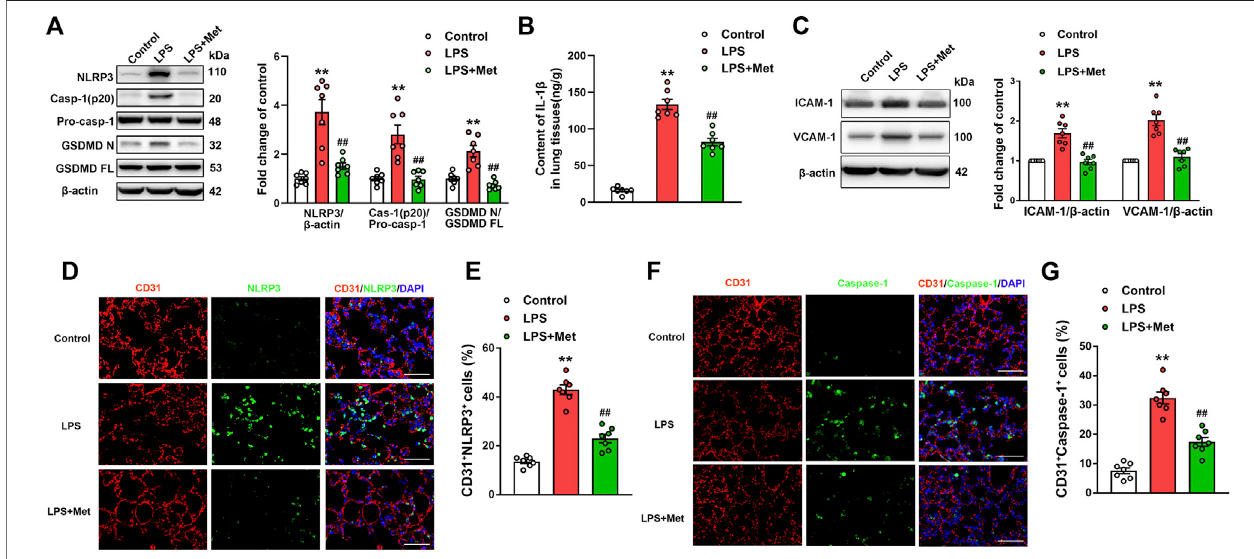
FIGURE 2 | Metformin reduces the LPS-induced release of pyroptotic proteins and vascular adhesion molecules in mouse lung tissues. (A) Western blotting was used todeterminethelevelsofNLRP3,cleaved caspase1(p20),andN-terminalfragmentofGSDMD.Indicativebandsareshown. (B) ELISAwasusedtodeterminethe protein levels of IL-1 β . (C) Representative protein bands and corresponding histogram of ICAM-1 and VCAM-1 are shown. (D) Lung tissues were stained with NLRP3 (green) and CD31 (red). Nuclei were counterstained with 4 ’ 6-diamidino-2-phenylindole (DAPI) (blue). (E) Percentages of CD31 + NLRP3 + cells are shown as histograms. (F) Lung tissues were stained with caspase-1 (green) and CD31 (red). Nuclei were counterstained with DAPI (blue). (G) Percentages of CD31 + Caspase-1 + cells are shown as histograms. Original magni fi cation, ×200. Scale bar, 50 μ m. Data are presented as the mean ± SEM ( n = 7). ** p < 0.01 vs. Control group, ## p < 0.01 vs. LPS